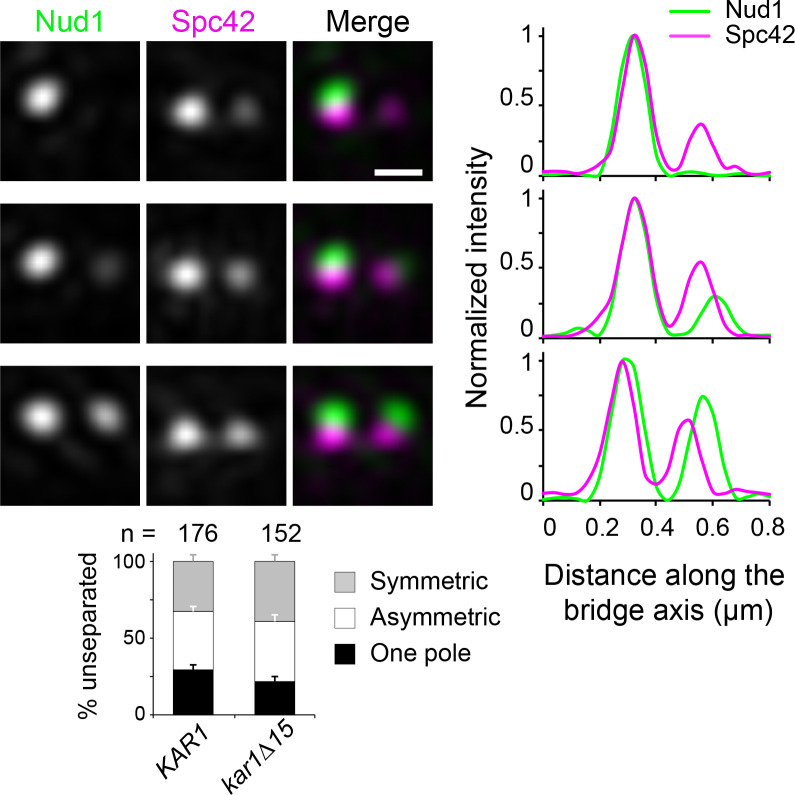
Modes of Nud1 localization in unseparated SPBs.Nud1-Venus (green) and Spc42-mT2 (magenta) were localized in KAR1 versus kar1∆15 cells by SIM. Three representative images show modes of label in unseparated SPBs. Consistent with the previously shown order of satellite assembly (Burns et al., 2015), Nud1 did not mark the presumptive satellite in approximately 25% of cells containing two Spc42 signals, but otherwise significantly accumulated at the new SPB toward the side-by-side stage. This is quantitated below.